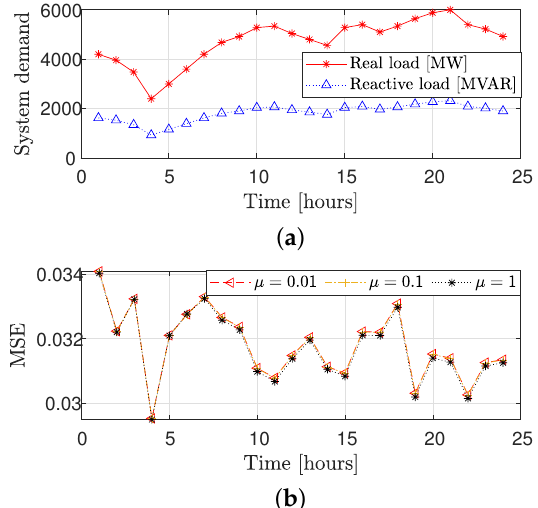
Figure 9. State estimation based on the DC − PF model: the hourly system demand ( a ) and the corresponding MSE of the GSP − WLS estimator (26) and (27) ( b ) versus time over 24 h for q = 48 buses and σ 2 =